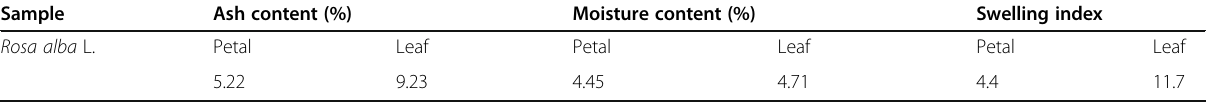
Table 1 Swelling index, moisture and total ash contents of the powder of petals and leaves of Rosa alba L Sample Ash content (%) Moisture content (%) Swelling index Rosa alba